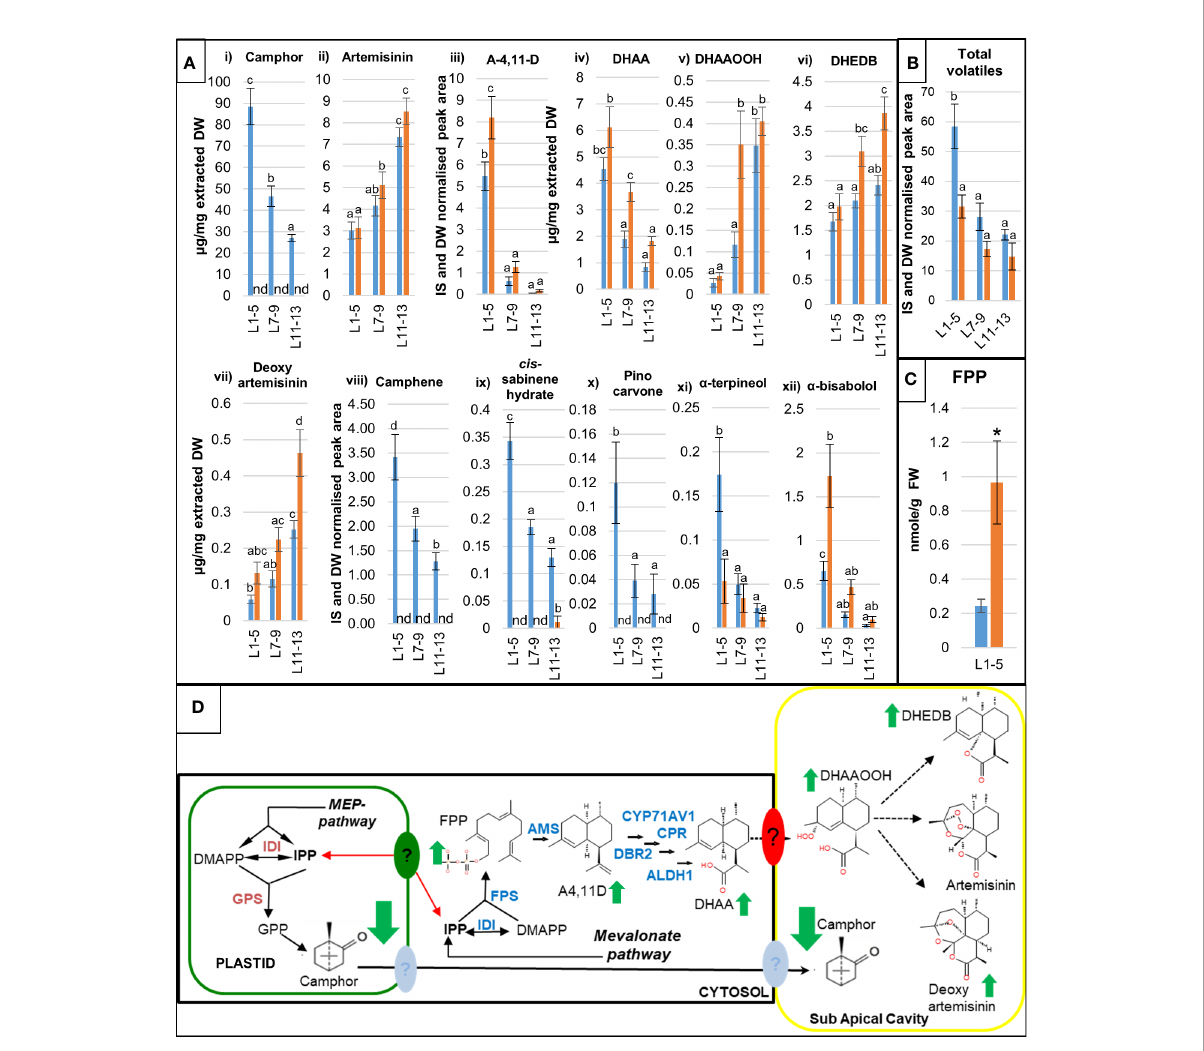
FIGURE 2 Detailed molecular characterization of camphor-0 M3 lines. Levels of artemisinin-related and other selected mono- and sesquiterpenes (A) were quanti fi ed by gas chromatography – mass spectrometry (GC-MS) (i) , (iii), (viii) - (xii) and ultra-high performance liquid chromatography – mass spectrometry (UPLC-MS) (ii), (iv)-(vii) analysis of extracts from fresh leaves L1-5 (juvenile), L7-9 (expanding), L11-13 (mature) as counted from the apical meristem from 12-weeks old glasshouse-grown Artemis F1 (blue bars) and selected camphor-0 M3 (orange bars); error bars – SE (n=5). nd - not detectable. GC-MS data for camphor were converted from internal standard (IS) and dry weight (DW) normalised peak areas to µg/mg extracted dry weight (vii) against a standard curve run with pure camphor. For both (A, B) letters represent Tukey ’ s range test results after one way ANOVA or REML. Groups not sharing letters indicate statistically signi fi cant differences. (B) Level of total volatiles measured by GC-MS in three types of leaf material as indicated in (A) . (C) Level of FPP measured in extracts from fresh juvenile leaves L1-5 Artemis F1 (blue bars) and selected camphor-0 M3 (orange bars); FW - fresh weight, error bars – SE (n=3), *- statistically signi fi cant difference (t-test) between Artemis and camphor-0 at p<0.05. (D) Summary of metabolite changes in the camphor-0 glandular secretory trichomes (GSTs), full arrows – known enzymatic steps, dotted arrows – potential non enzymatic conversions, full green arrows – metabolite changes (all leaf stages). Metabolite abbreviations: GPP - geranyl diphosphate, FPP – farnesyl diphosphate, A-4,11-D – amorpha-4,11-diene, DHAA - dihydroartemsinic acid, DHAAOOH- dihydroartemisinic acid tertiary hydroperoxide, DHEDB – dihydro-epi-deoxyarteanniun B, Enzyme abbreviations: IDI - Isopentenyl Diphosphate Isomerase, GPS - Geranyl diPhosphate synthase, BPS - Bornyl diPhosphate synthase, FPS- Farnesyl diPhosphate Synthase. Artemisinin pathway: AMS – amorpha-4,11-diene synthase, CYP71AV1 - amorpha-4,11-diene C-12 oxidase, CPR – cytochrome P450 reductase, DBR2 - artemisinic aldehyde D 11 (13) reductase, ALDH1 - aldehyde dehydrogenase. Question marks indicate putative active